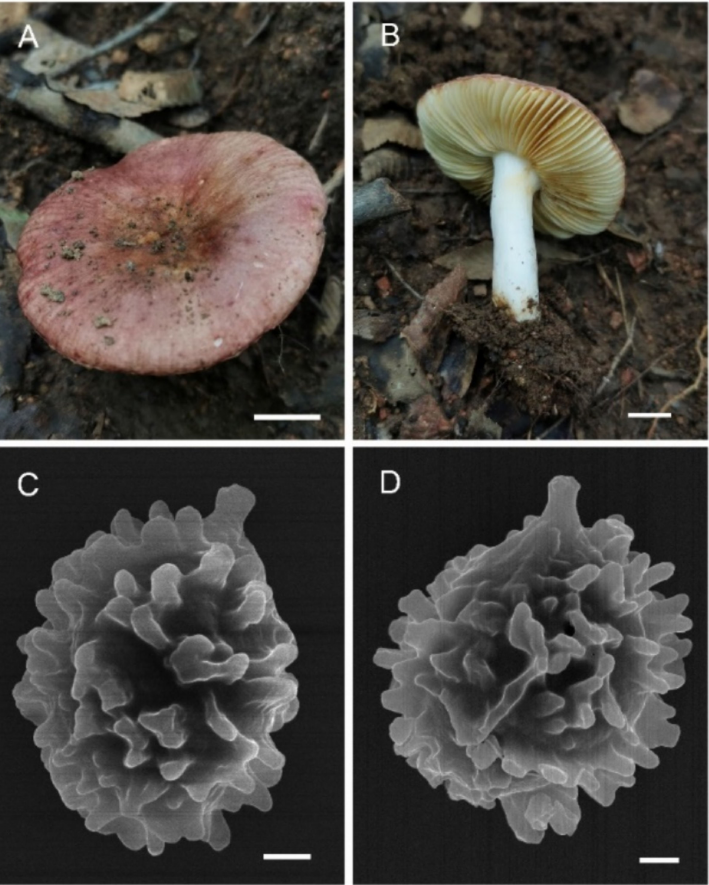
Figure 19. Russula subversatilis (BJTC C653). ( A , B ) Basidiomata. ( C , D ) Basidiospores. Scale bar: ( A , B ) = 10 mm, ( C , D ) = 1 µ m.